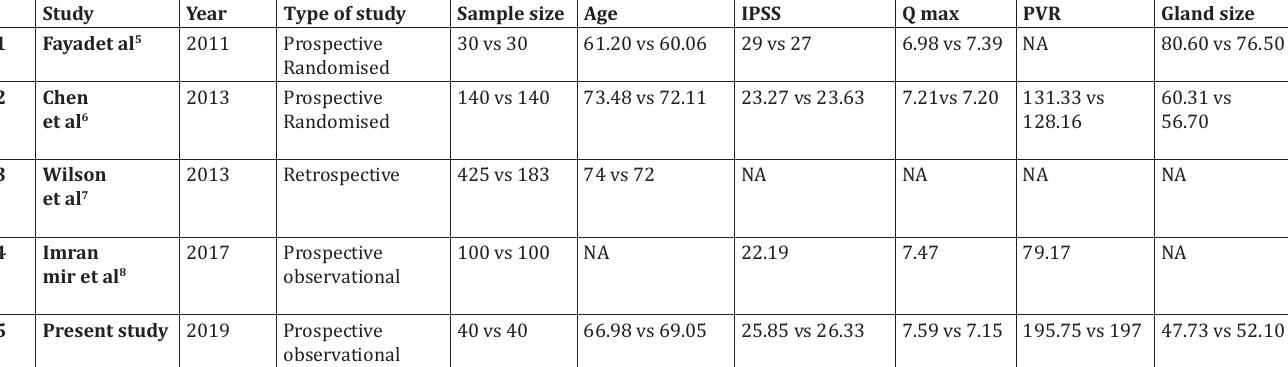
Base line comparision of study groups with other studies on bipolar turp and holep (TURP versus